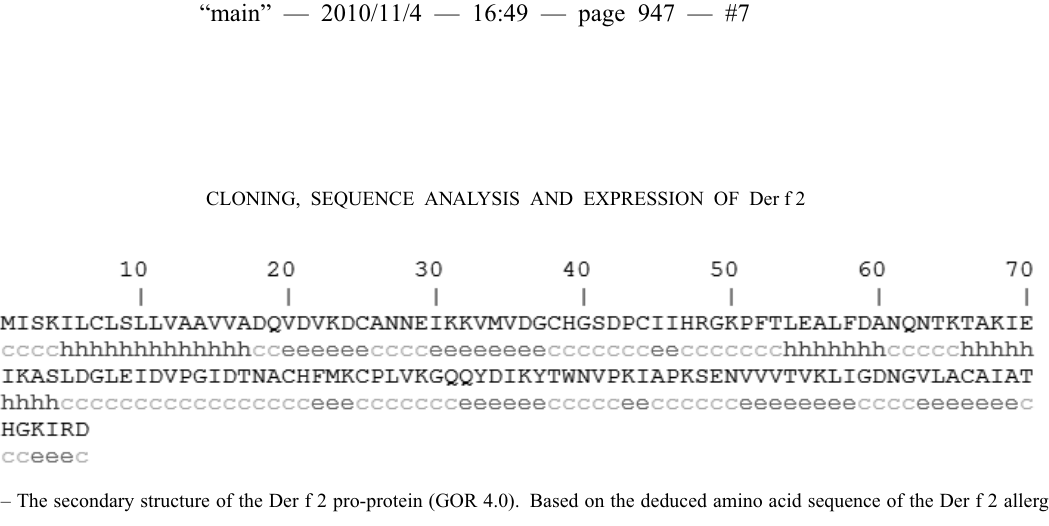
Fig. 3 – The secondary structure of the Der f 2 pro-protein (GOR 4.0). Based on the deduced amino acid sequence of the Der f 2 allergen, its secondary structure was predicted as described in “Materials and Methods”. Alpha helix (Hh): 29 (19.86%); extended strand (Ee): 45 (30.82%); and random coil (Cc): 72 (49.32%).